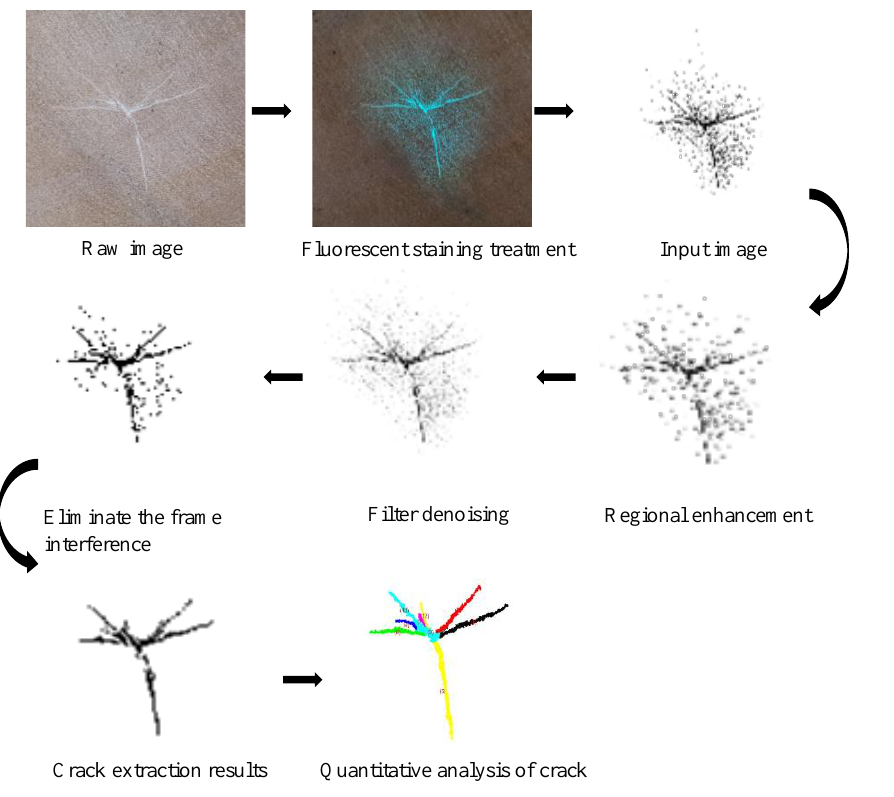
Figure 7. Identification of crack images.